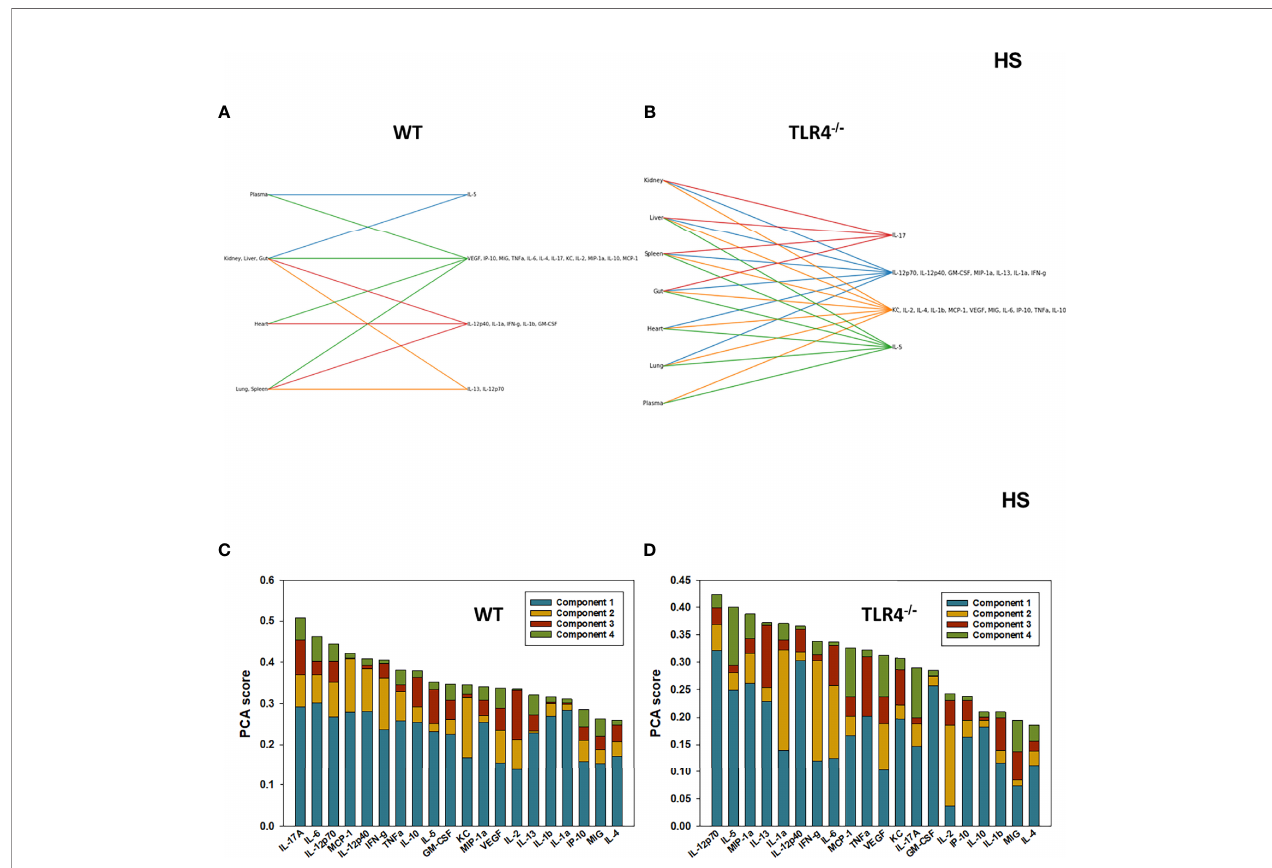
FIGURE 3 | Hypergraphs and Principal Component Analysis of in fl ammatory mediators from WT and TLR4 -/- mice subjected to HS. Plasma and tissue samples from heart, lung, liver, gut, spleen, and kidney were collected from WT and TLR4 -/- mice subjected to HS and analyzed using Luminex ™ as described in Materials and Methods. Panels (A, B) show the hypergraphs and Panels (C, D) show the PCA results (70% variance) in WT and TLR4 -/- mice,